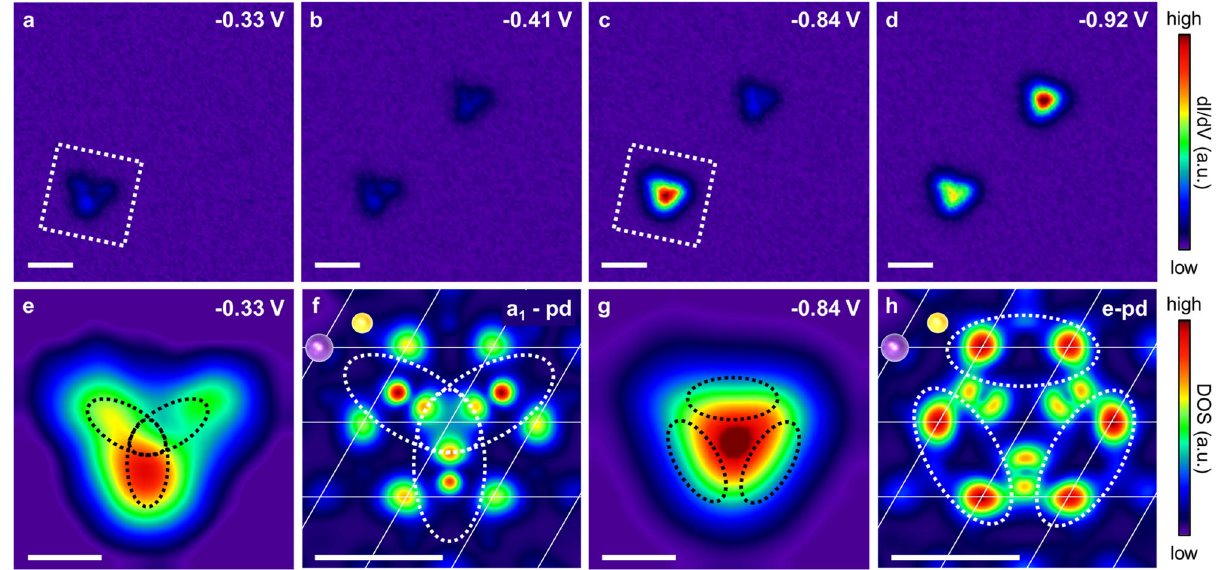
Fig. 4 Spatial distribution of the a 1 -pd and e-pd states around two molybdenum vacancies. a – d A series of four CITS maps acquired over the same location shown in Fig. 2a with the energy of each map shown in the upper right corner of their respective panels. Scale bars represent 1 nm. e The map acquired at − 0.33 eV magnifying the defect outlined in the white dashed box in ( a ). f The real-space projection of the density of states at the energy of the a 1 -pd defect state at a level of 0.1 Å above the upper Sulfur layer. g The map acquired at − 0.84 eV magnifying the defect outlined in the white dashed box in ( c ). h The real-space projection of the density of states at the energy of the e-pd defect state at a level of 0.1 Å above the upper Sulfur layer. Scale bars for ( e – h ) represent 0.5 nm. The grid of white lines in ( f , h ) represents the horizontal primitive cells of the MoS 2 where the purple and yellow spheres in the upper left-hand corner indicate the positions of the molybdenum and sulfur atoms, respectively.